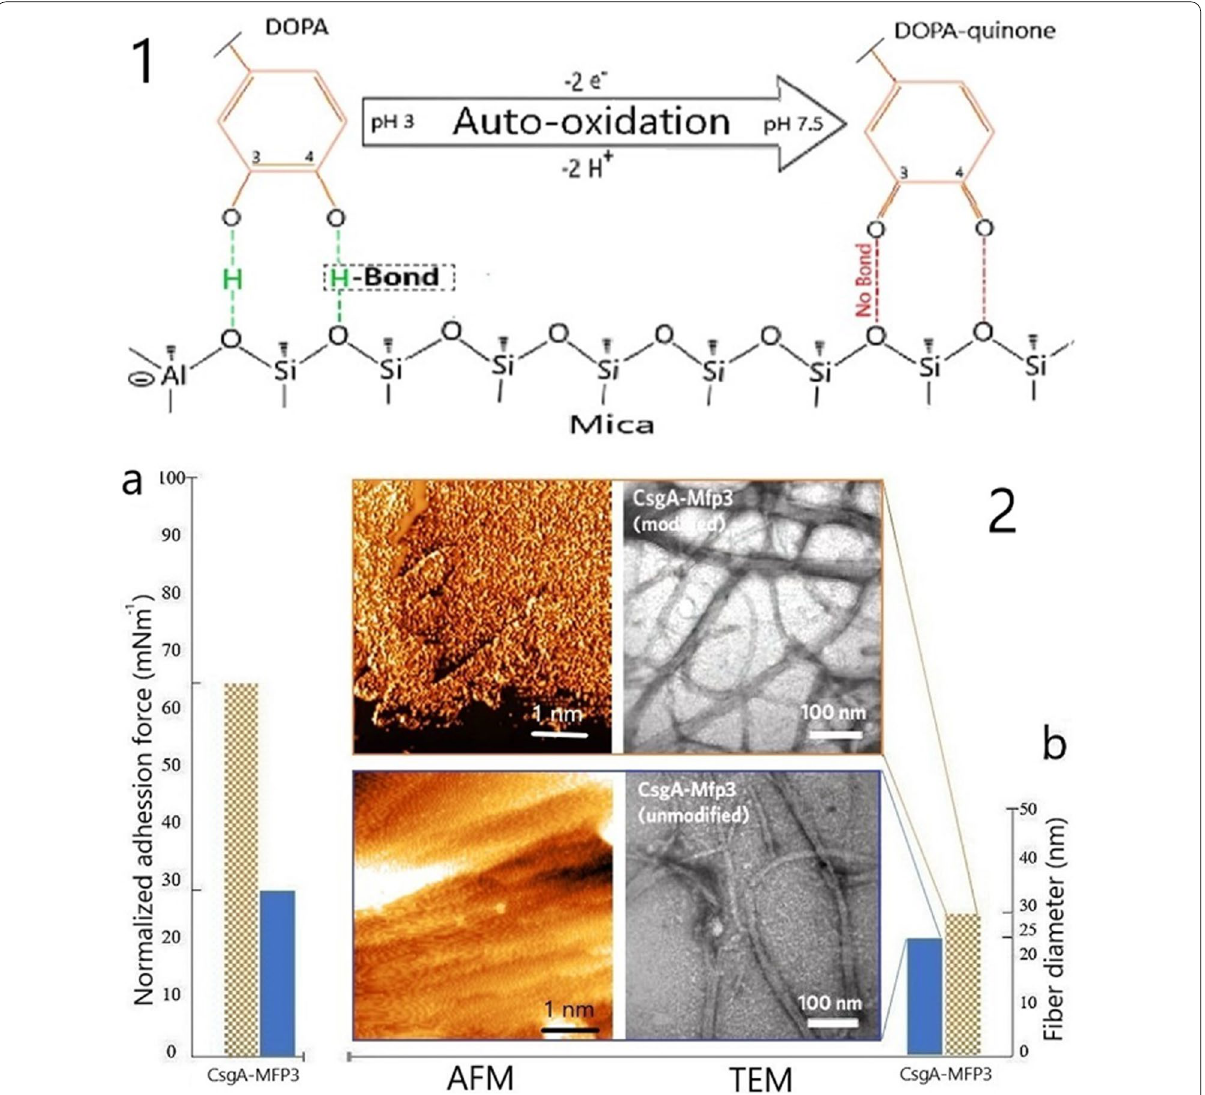
Fig. 10. 1 Influence of auto-oxidation and pH scale on the formation of adhesive bonds. At pH 3, a more than twice the increase in the adhesive force of the modified case on the PS (polystyrene) surface by mNm − 1 unit, compared to the unmodified version. b Size of the fibre diameter from AFM and TEM images for modified and unmodified versions of CsgA-MFP3 fibre after 3 days of incubation at 4 °C. There are important differences between unmodified and modified images of CsgA-MFP3 fibres based on approximately 5-nm differences between the amounts of fibre